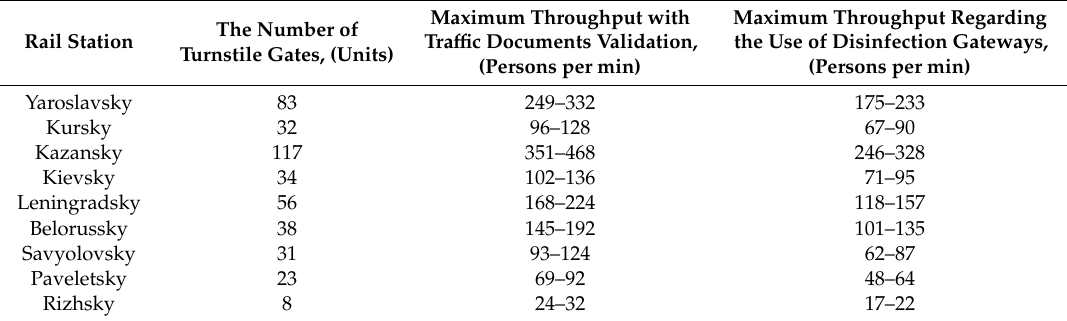
Table 5. Evaluation of the throughput of the entry groups, equipped with turnstile gates, at the rail stations in the city of Moscow, regarding the use of disinfection